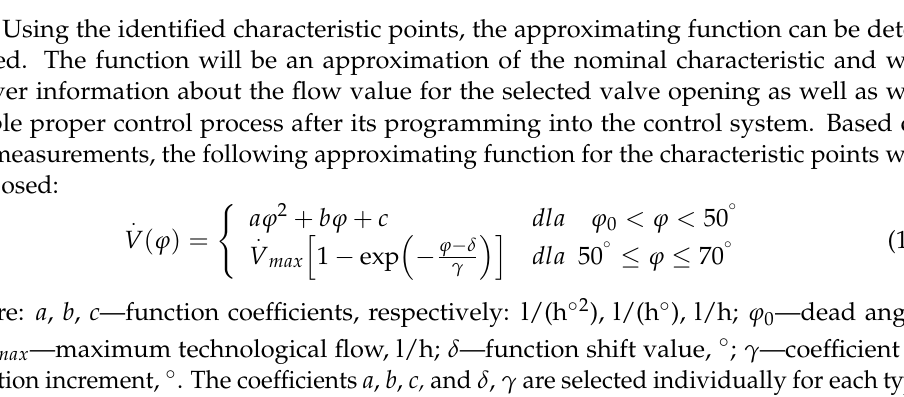
Figure 8. Tests of dynamics of flow meter readings and actuator position angle for